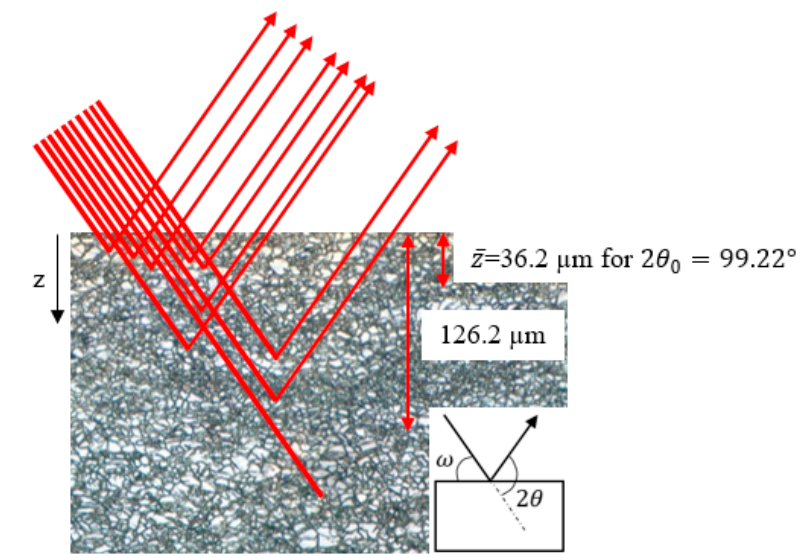
Figure 2. X-rays di ff racting from di ff erent locations through the depth, 36.2 and 126.2 µ m showing 50% Figure 2. X-rays diffracting from different locations through the depth, 36.2 and 126.2 μ m showing ◦ and 90% ray di ff raction, when using Cu-K α for 2 θ = 99.22 in Mg 50% and 90% ray diffraction, when using Cu-K α for 2𝜃 = 99.22° in Mg substrate.